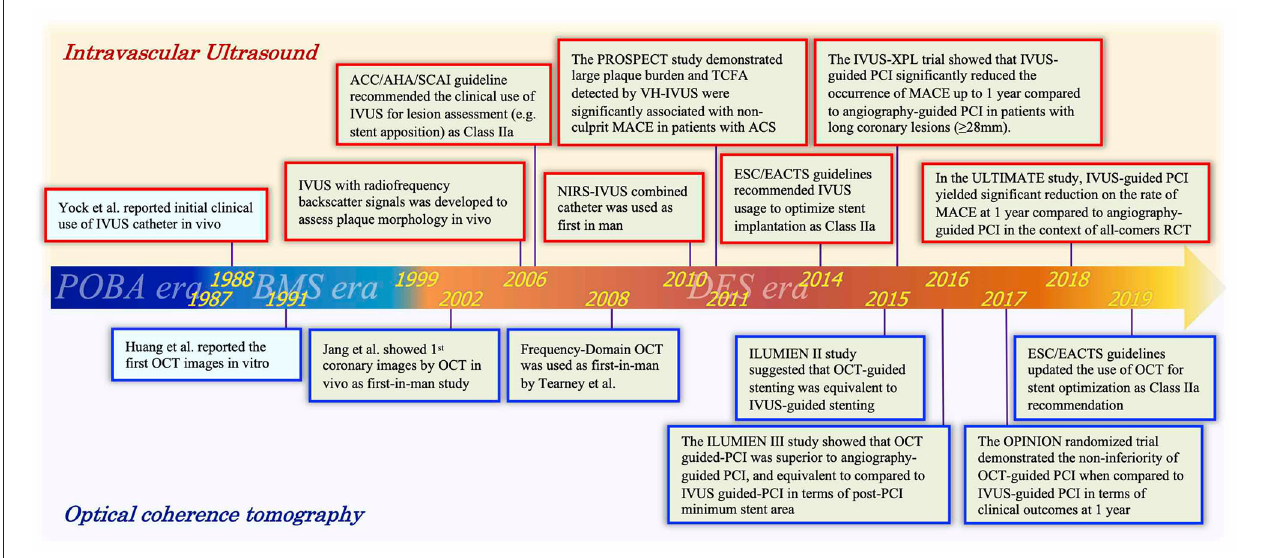
FIGURE 1 | Timeline of intravascular ultrasound and optical coherence tomography with advances of PCI era. A history focused on intracoronary imaging devices (IVUS and OCT). Red and blue frames indicate representative events associated with IVUS and OCT, respectively. IVUS, intravascular ultrasound; OCT, optical coherence tomography; POBA, plain old balloon angioplasty; BMS, bare-metal stent; DES, drug-eluting stent; PCI, percutaneous coronary intervention; ACC, American College of Cardiology; AHA, American Heart Association; SCAI, Society for Cardiovascular Angiography; ESC, European Society of Cardiology; EACTS, European Association for Cardio-Thoracic Surgery; MACE, major adverse cardiac